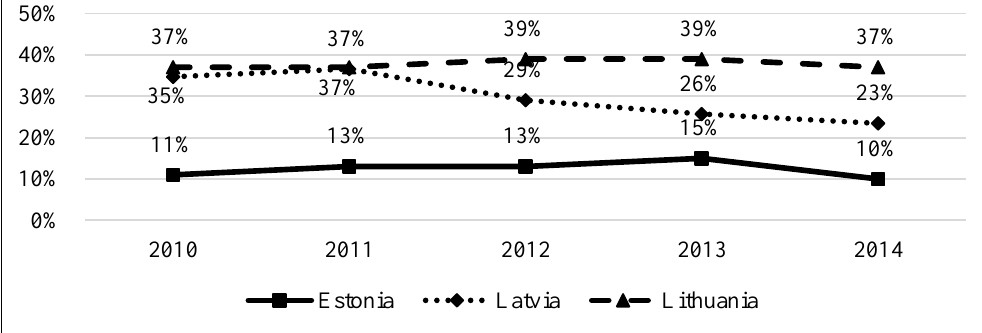
Fig. 1. VAT GAP, as the percentage of VAT of Total Tax Liability in Estonia, Latvia and Lithuania (developed by the author; TAXUD,